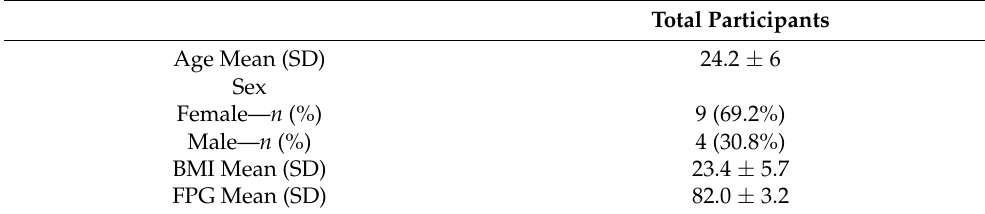
FPG—Fasting Plasma Glucose; BMI- Body Mass